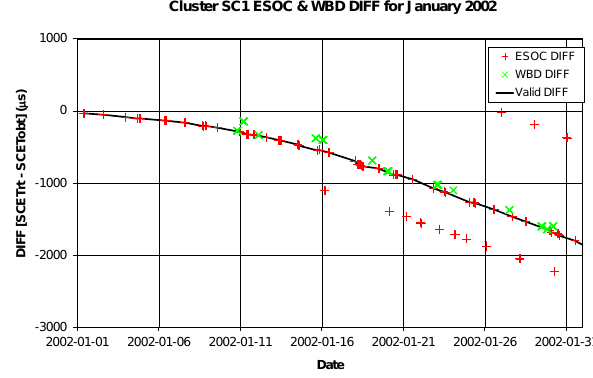
Fig. 1. Plot of the DIFF values measured by ESOC ( + ) and WBD ( × ). The solid line represents the assumed correct value used to pre- pare the time corrections. The “DIFF” (the difference between the ground receive time and the onboard time) is measured during every ground station contact. However some measurements are subject to errors, so a validation process must be